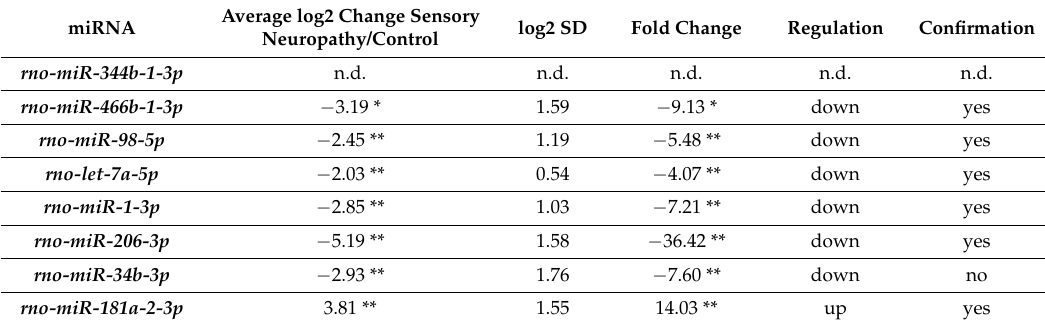
Table 4. Validation of microarray analysis by